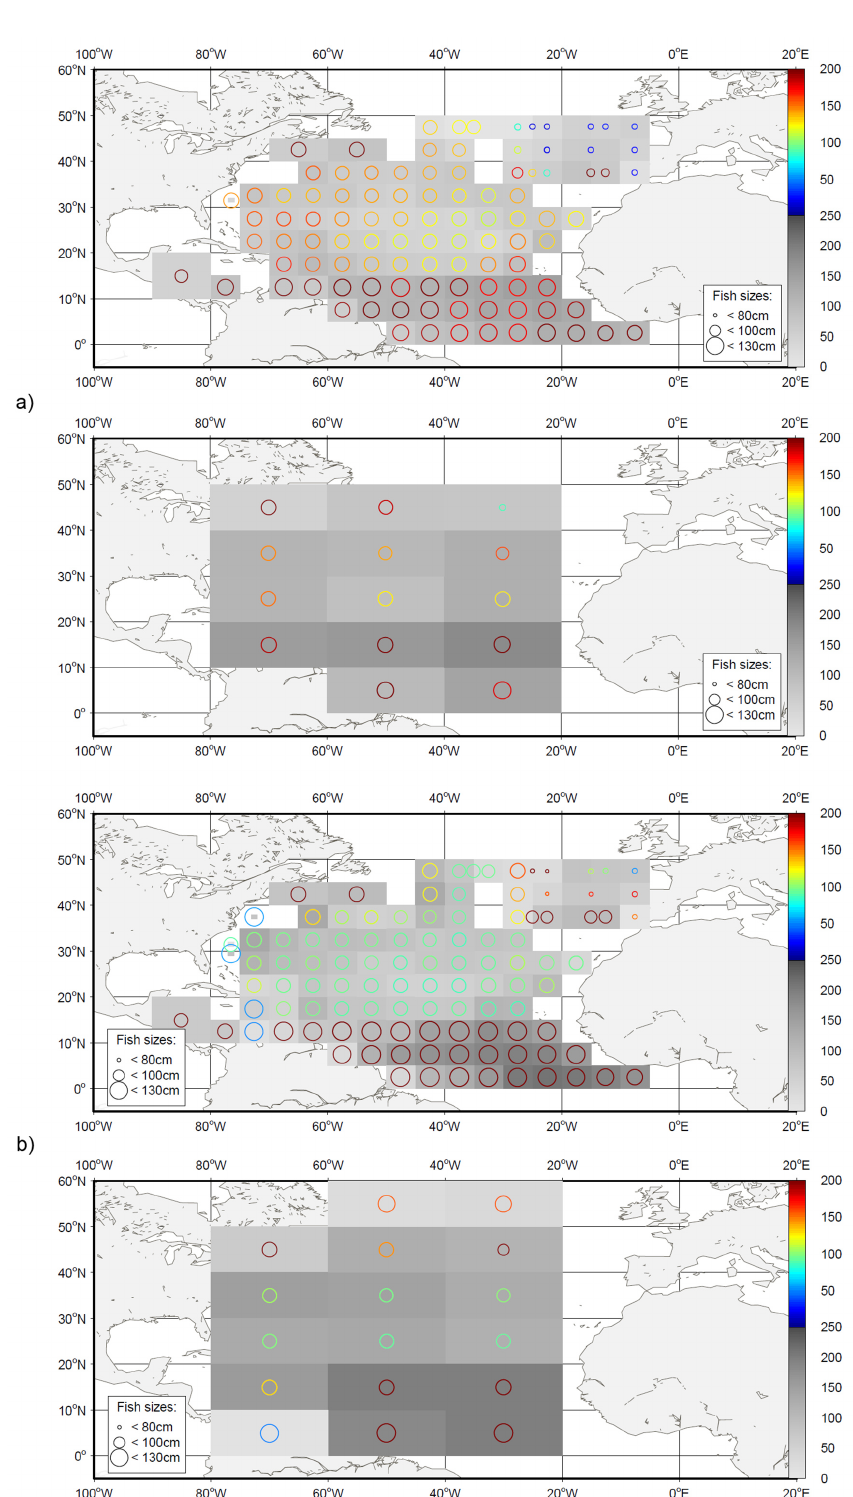
www.earth-syst-sci-data.net/6/317/2014/ Earth Syst. Sci. Data, 6, 317–329,